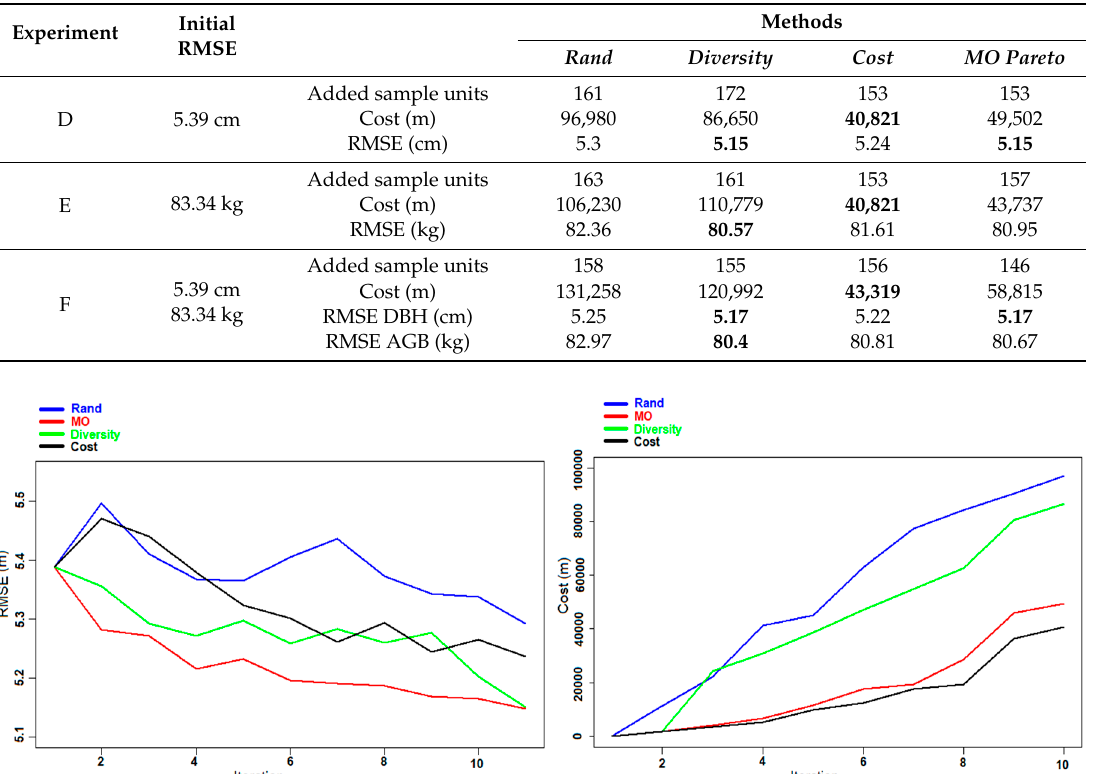
Table 4. Results obtained for the Hadeland dataset (experiments D, E, and F). The initial RMSE is the RMSE obtained on Hadeland test set using only the Våler training set to build the model. The best results are highlighted in bold.